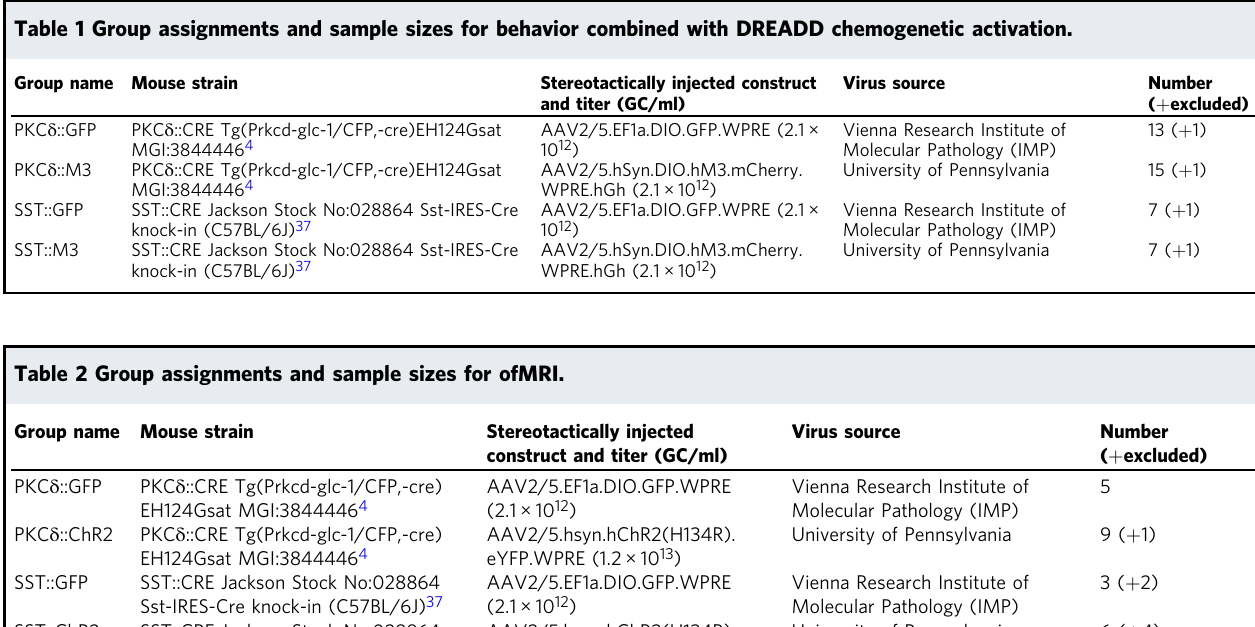
Fig. 3 Summarized changes in functional connectivity (FC) evoked by optogenetic or laser-heat co-stimulation in CEl (compared to respective GFP controls). a Pure optogenetic activation of CEl PKC δ + neurons (left top) reduced FC within the lower-level (light gray spheres) brain regions thalamus, basal forebrain, and brainstem. Optogenetic activation of CEl SST + neurons (left bottom) reduced FC in three distinct subnetworks: one higher-level (orange spheres) cortical (cxAss, cxCg, cxM, cxS1) and two lower-level subcortical (Am and Hy; CPu, Hc, and Bs). Optogenetic modulation of nociception using laser- heat co-stimulation of PKC δ + neurons (right top) modulated a vast network of brain regions, particularly a circuit involving the amygdala, hypothalamus, hippocampus, basal forebrain, and primary sensory cortex. Even though FC is generally undirected, possible directions may be derived from the underlying directed structural connectivity 16 . This indicated that CE controlled BFB and Hy as key nodes, which then modulated the higher-level brain regions. Co- stimulation of SST + neurons (right bottom) during heat stimulation in fl uenced a very con fi ned network of regions. Structural connectivity indicated that CE controlled higher-level cortical regions (cxS1, cxM, cxCg) and Hc directly and indirectly via Bs. Projection paths of CEl PKC δ + and SST + neurons indicated by solid black lines = major and direct, dotted black lines = minor and indirect. To ease interpretation of the data, changes in FC were pseudo-directed ( “ synapses ” forming on the target region), using information from anterograde tracing studies (Allen brain atlas 16 ). The unit of FC used here represents summed up signi fi cant changes between CEl PKC δ + , SST + and their corresponding GFP controls in negative and positive correlations (homoscedastic two-tailed Student ’ s t test, P ≤ 0.05, uncorrected; compared to the matching controls; n PKC δ ::GFP = 5, n SST::GFP = 3, n PKC δ ::ChR2 = 9, n SST::ChR2 = 6). Meaning, a net FC of − 6 here in this picture represents six signi fi cantly different connections (positive and/or negative Pearson r) that were greater in GFP than in the ChR2 group, or, for example,